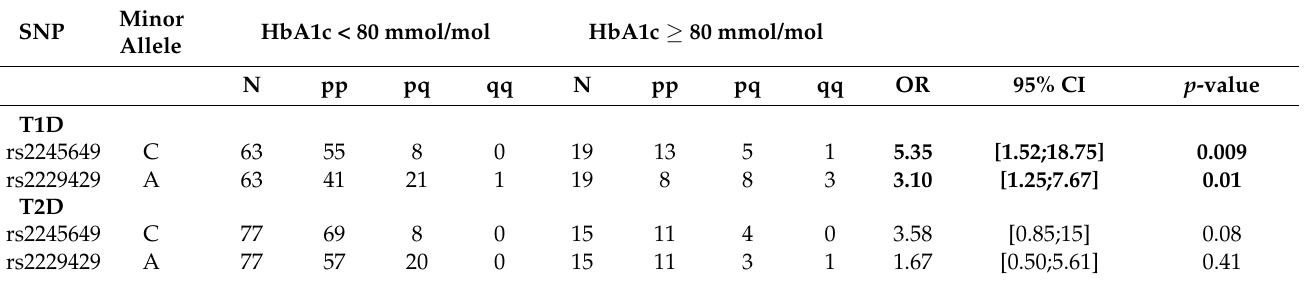
Table 3. Associations between selected polymorphisms in the INSR gene and poor glycaemic control in T1D and